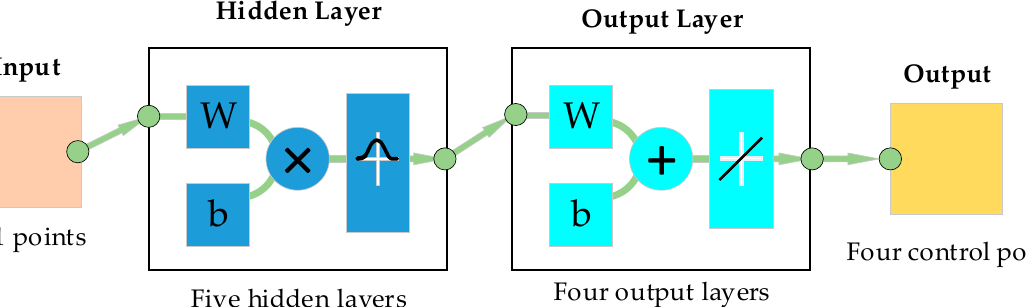
Figure 16. Trained radial basis function neural network.